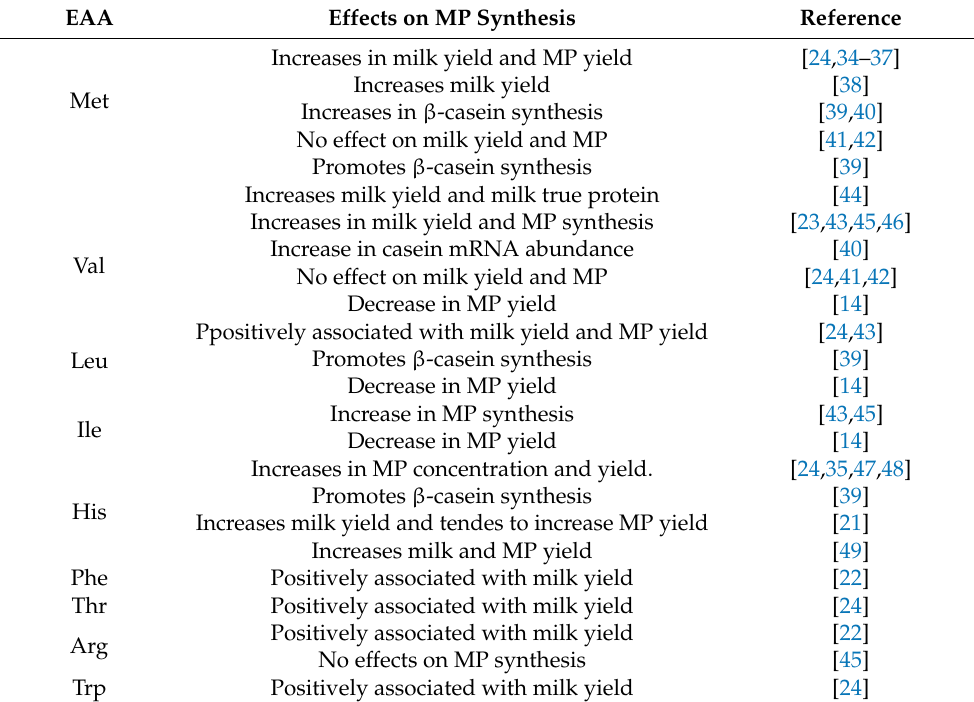
Table 1. Some recent studies on the effects of EAAs on MP synthesis in dairy